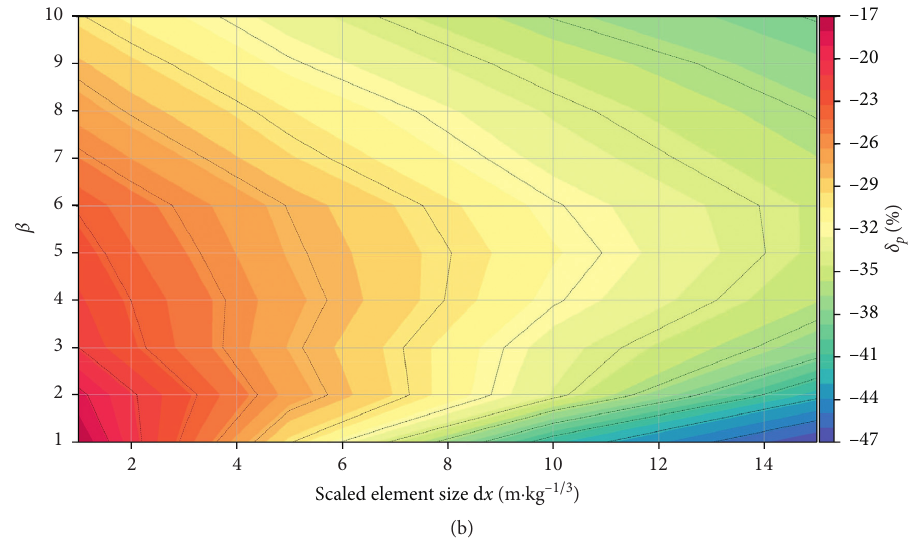
Figure 12: Relative peak of overpressure difference with UFC-3-340-2 for all beta parameter and all studied scaled mesh sizes.